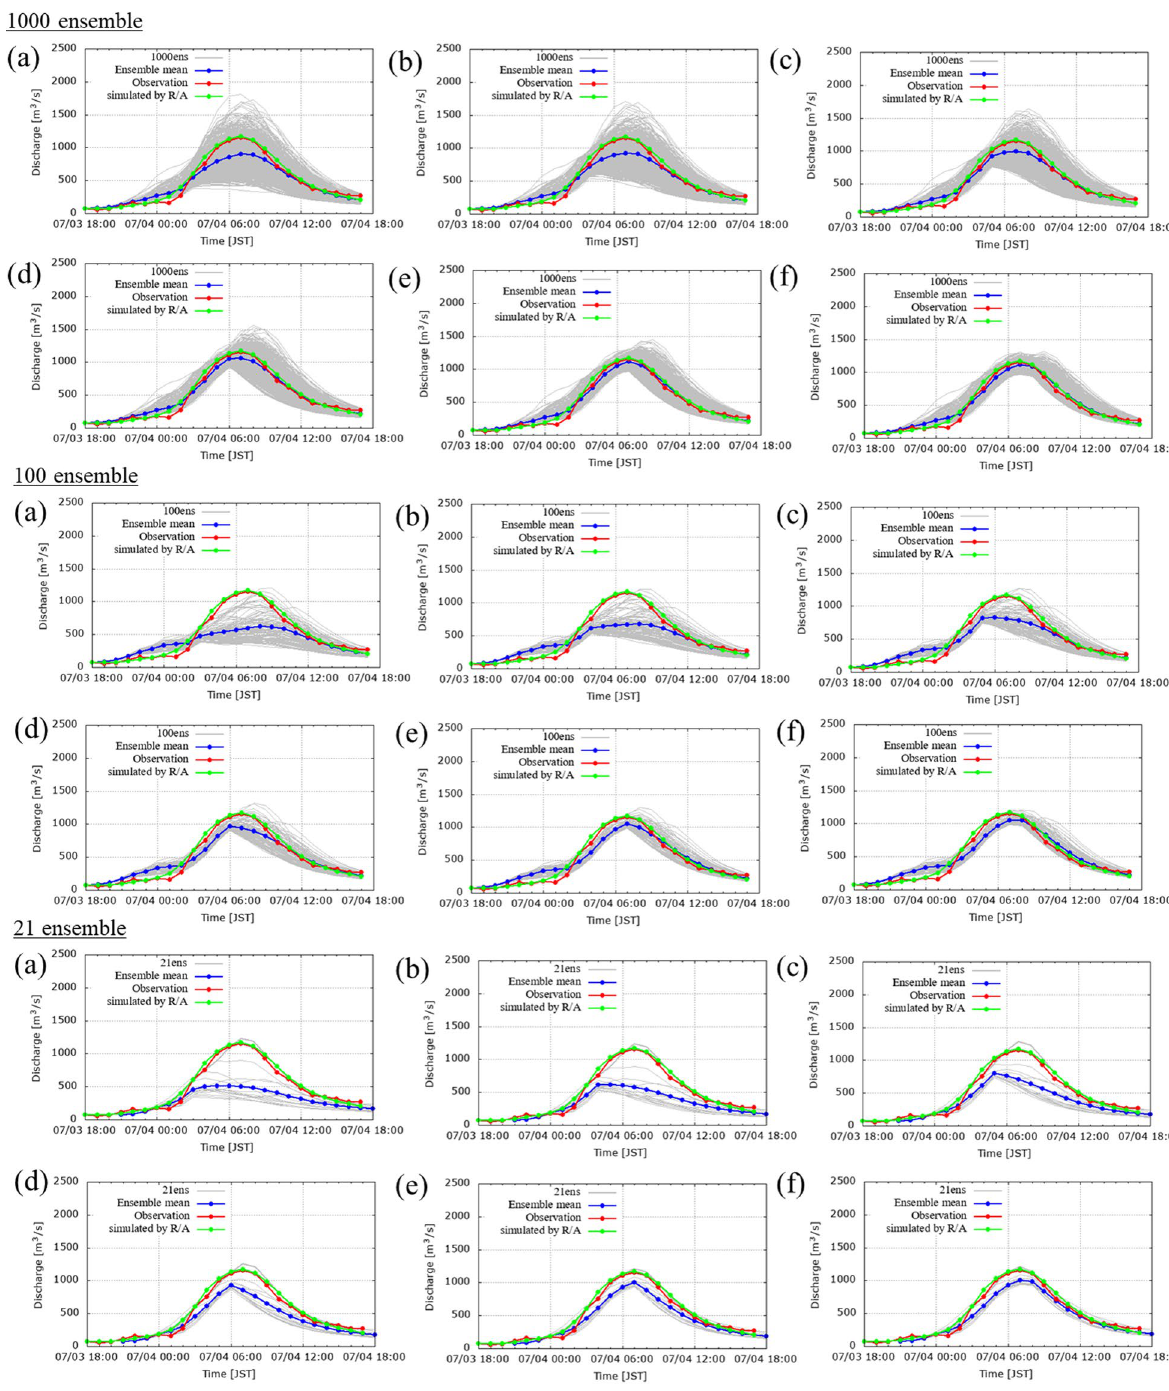
Fig. 17 Application of the Kalman filter on the discharge simulations of 21, 100 and 1000 ensembles for Ichifusa dam ( a – g ): The Kalman filter was applied until: a 11, b 12, c 13, d 14, e 15 and f 16